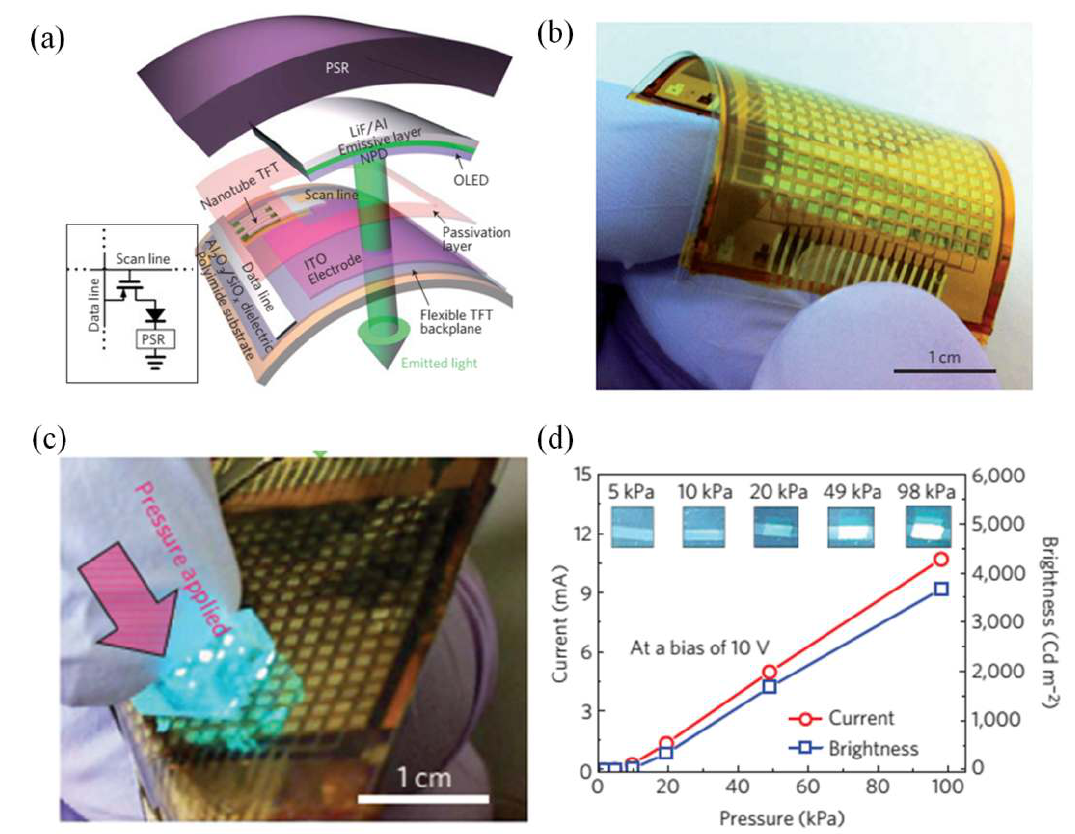
Figure 9: (a) Schematic layout of a single device on the user-interactive e-skin, including a TFT, OLED, and pressure sensor integrated in the whole system. (b) Optical image of a fabricated user-interactive e-skin device under bending. (c) A photograph of the device respond- ing to the external pressure. The OLED turned on at the pressing location. (d) Device performance of the e-skin under different pressures. Reprinted with permission from Macmillan Publishers Ltd: [Nature Materials] [71], copyright